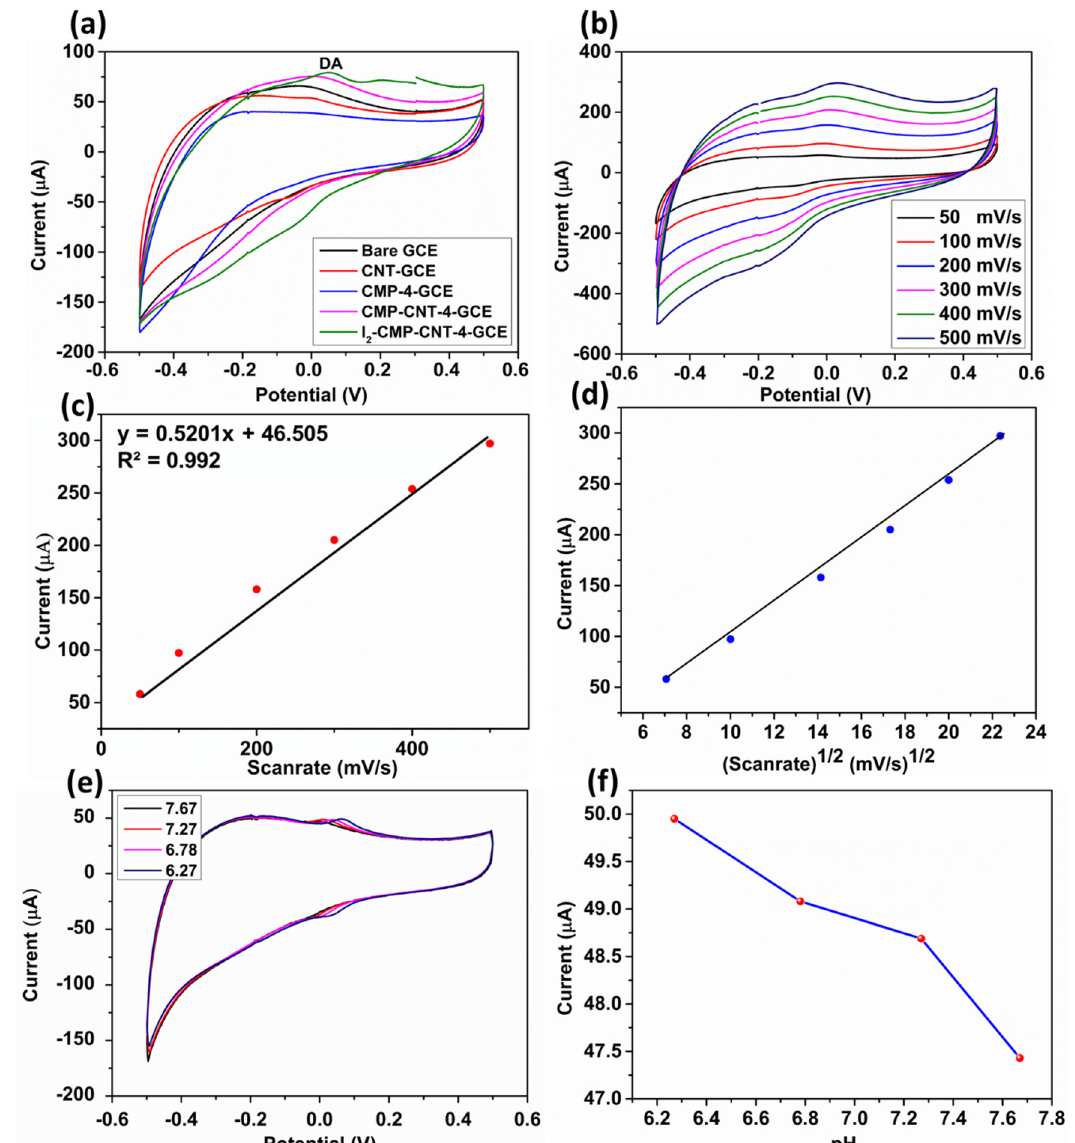
Figure 3. ( a ) CV curves of the bare GCE, CNT ‐ modified GCE, CMP ‐ 4 ‐ modified GCE, CMP ‐ CNT ‐ 4 ‐ modified GCE, and I 2 ‐ CMP ‐ CNT ‐ 4 ‐ modified GCE in 4 μ M DA, ( b ) CV plot for peak current vs. scan rate from 50 to 500 mV/s in 4 μ M DA, ( c ) linear regression plot for peak current vs. scan rate from 50–500 mV/s, ( d ) linear plot for peak current vs. (scan rate) 1/2 from 50–500 mV/s, ( e ) CV plot for 1 μ M DA at different pH, and ( f ) linear plot for peak current vs. pH in 1 μ M DA at different pH.